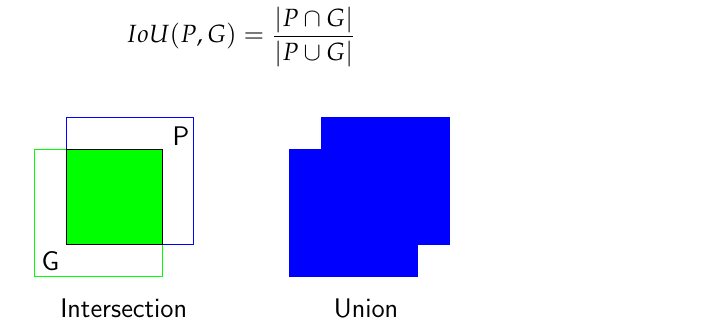
Figure 5. Graphical definition of intersection over the union between a ground-truth bounding box (G) containing a pollen grain and the location (P) of the grain predicted by the network.